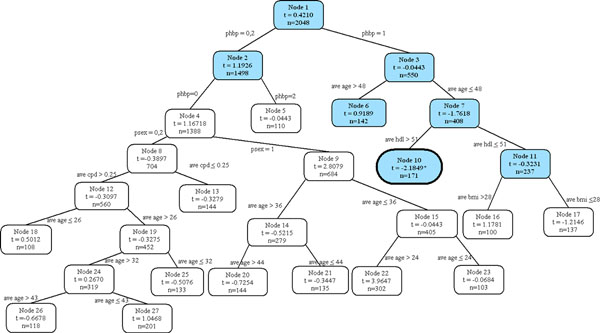
Tree for D17S2180, overgrown (a) and pruned to optimal tree (b, shaded). Each split is labeled with split criterion. Each node is labeled with node number and t-value obtained from the regression of squared sib-pair difference of systolic blood pressure on IBD for the subgroup of sib pairs at each node and the number of sib-pairs in the node.